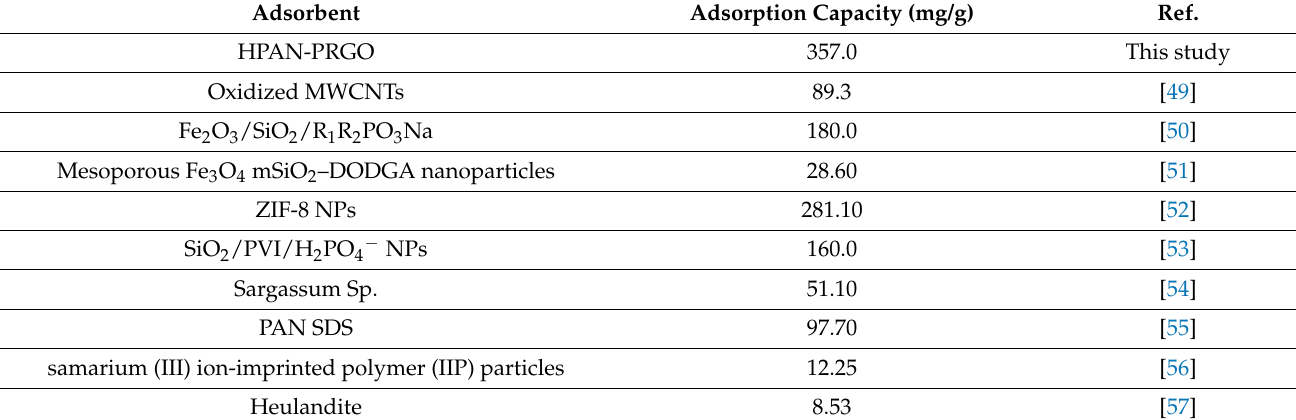
Table 2. Comparison between the removal of Sm 3+ ions over HPAN-PRGO nanocomposite and previous studies.